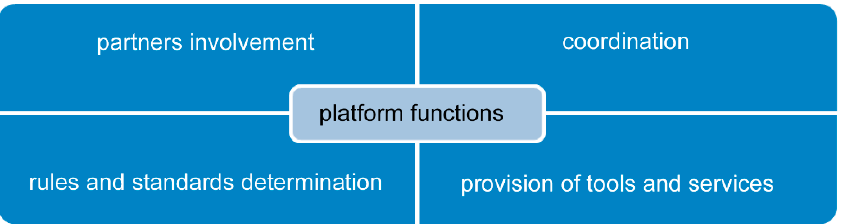
Figure 4. Basic platform partner